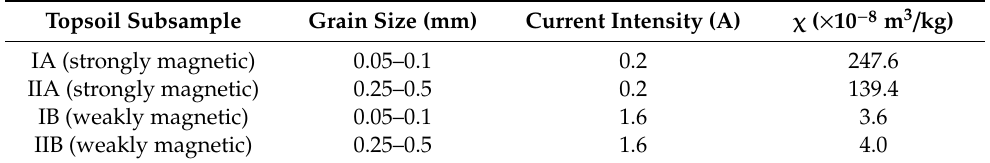
Table 1. Mass-specific magnetic susceptibility ( χ ) of topsoil subsamples after sieve and magnetic separation. Topsoil